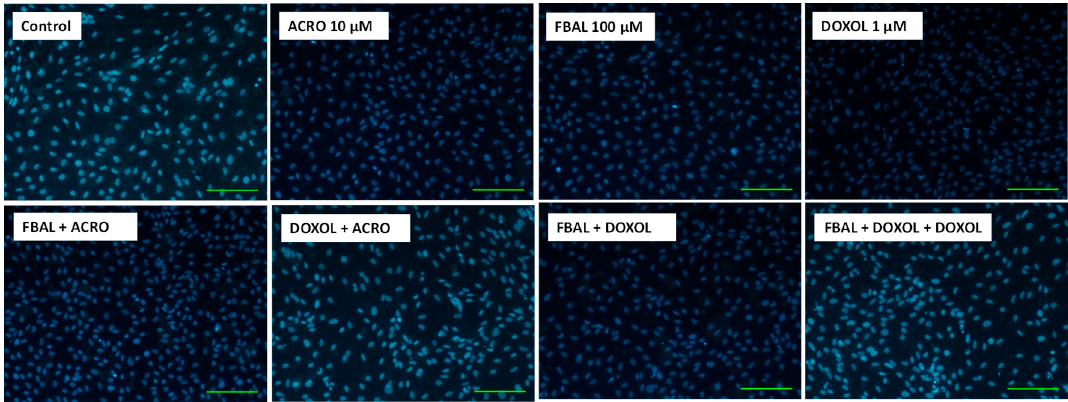
Figure 9. Fluorescence microscopy (Hoechst 33258 staining) of differentiated H9c2 cells after a 48 h exposure to the metabolites (FBAL 100 μ M, DOXOL 1 μ M, ACRO 10 μ M) and their combination. Images are representative of two independent experiments. Scale bar: 100 μ M.